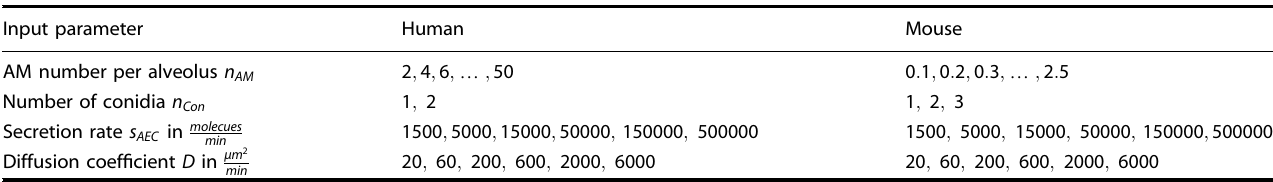
Table 1. Summary of screened parameters for the human and murine